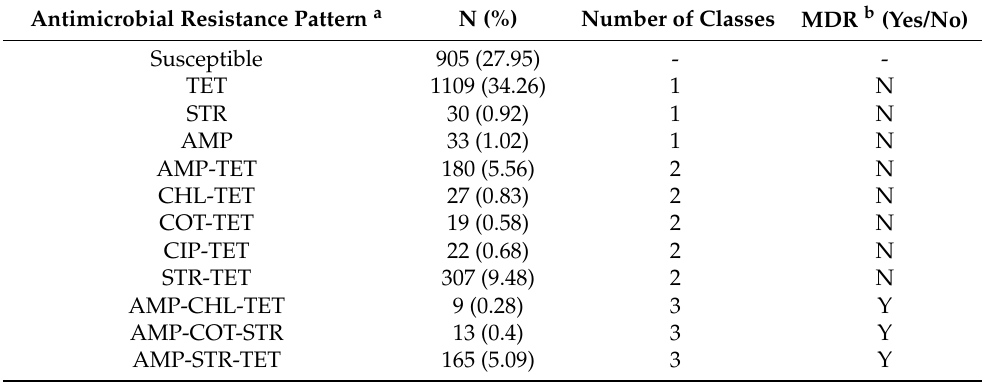
Figure 3. Clustering dendrogram (heatmap) of antimicrobial resistance in commensal Escherichia coli isolated from swine at slaughter across the US, 2013–2019. AMC ‒ Amoxicillin-Clavulanic acid; AMP ‒ Ampicillin; AXO ‒ Ceftriaxone; AZI ‒ Azithromycin; CHL ‒ Chloramphenicol; CIP ‒ Cipro fl oxa- cin; COT ‒ Trimethoprim-Sulfamethoxazole; FOX ‒ Cefoxitin; GEN ‒ Gentamicin; NAL ‒ Nalidixic Acid; STR ‒ Streptomycin; TET ‒ Tetracycline. Table 1. Most common antimicrobial resistance patterns in commensal E. coli (n = 3007) isolated from cecal swine samples at slaughter across the United States,